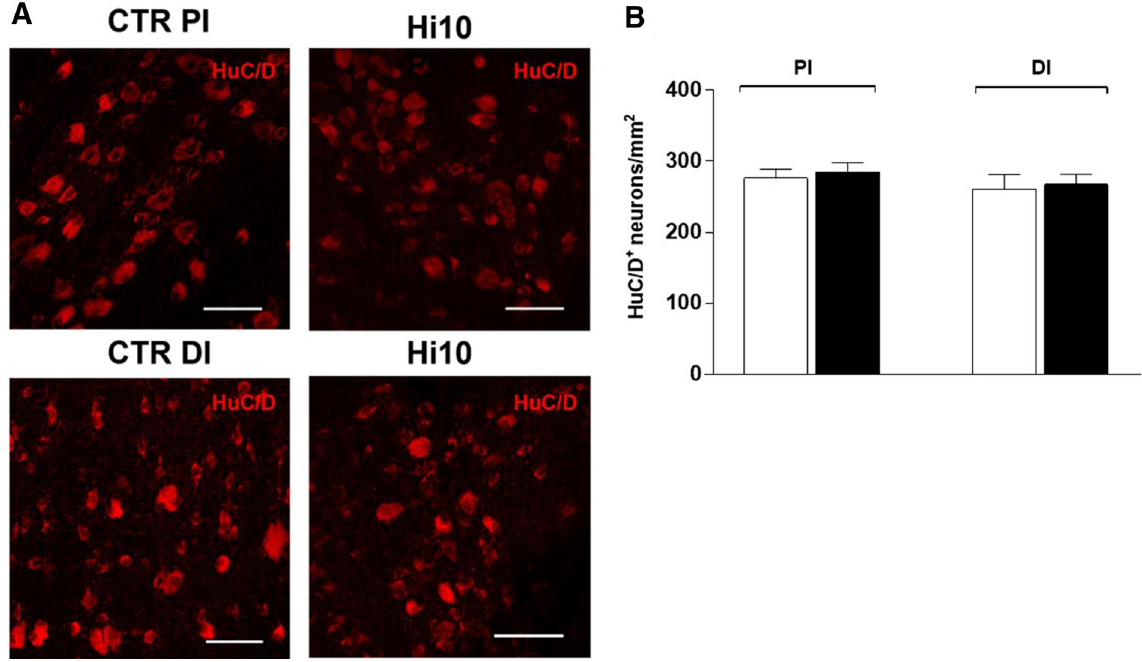
Figure 2. Density of myenteric neurons in longitudinal muscle myenteric plexus (LMMP) whole mounts of the proximal and distal gilthead sea bream. ( A ) HuC/D staining in LMMP preparations of the proximal and distal gilthead sea bream intestine obtained from fishmeal fed (CTRL) and Hermetia illucens 10% (Hi10) fed fish. Bars: 50 µm. ( B ) Number of myenteric neurons per mm 2 staining for HuC/D in gilthead sea bream proximal (PI) and distal (DI) intestine obtained from CTRL (empty bars) and Hi10 (black bars) animals. Values are given as mean ± SEM (n = 5 neurons, normalized per area (mm 2 ), was similar (proximal CTRL: 276.4 ± 12.87; proximal Hi10: 284.5 ± 13.6; distal CTRL: 261.1 ± 20.50; distal Hi10: 267.9 ± 14.17, N = 5; (data expressed as mean ± SEM) (Fig. 2 panel B). Gastrointestinal transit in CTRL and in Hermetia illucens fed gilthead sea bream. Partial sub- stitution of fishmeal with Hermetia illucens meal affected gilthead sea bream gastrointestinal motor function, as suggested by the slower gastrointestinal transit as compared to CTRL animals (Fig. 3, panel A). This is reflected by the significant ( P < 0.01) reduction in the geometric center (GC) of fluorescence distribution in Hi10 animals with respect to the value obtained in CTRL animals (Fig. 3, panel B). Gastric emptying was not significantly modified by Hermetia illucens meal as compared to CTRL diet (Fig. 3, panel C). Hermetia illucens meal influences the excitatory neuromuscular contractility of the proximal and distal intestine in gilthead sea bream. The longitudinal muscle of the proximal (PI) and distal (DI) intestine of CTRL animals showed spontaneous movements consisting of regular pendular contractions, which were significantly higher ( P < 0.01) in the distal than in the proximal intestine (Supplementary Table S2). In both intestinal regions, the amplitude of spontaneous contraction was significantly reduced after feeding with Hermetia illucens meal as compared to the relevant CTRL value (PI: P < 0.001; DI: P < 0.05). The frequency of spontaneous basal contractions was significantly higher in the proximal intestine than values obtained in the dis- tal intestine ( P < 0.01) (Supplementary Table S2). In both intestinal regions, Hermetia illucens meal significantly reduced the frequency of spontaneous contractions with respect to the relevant CTRL value ( P < 0.05 for both PI and DI; Supplementary Table S2). To evaluate the influence of Hermetia illucens meal on the excitatory neuromuscular response, non- cumula- tive concentration–response curves to the non-selective cholinergic agonist carbachol (CCh), were performed on longitudinally oriented proximal and distal intestine segments from all experimental groups. In the proximal intestine of the CTRL group, the concentration–response curve to CCh was lower than that obtained in the distal intestine of CTRL animals, with a significant decrease in maximum response (Emax) ( P < 0.0001) (Fig. 4, panel A). Hermetia illucens meal did not influence concentration–response curves to CCh in the proximal intestine as compared to CTRL fishmeal, whereas in the distal intestine, the insect meal induced a significant downward shift of the CCh concentration–response curve, with a significant reduction in Emax as compared to CTRL conditions ( P < 0.0001) (Fig. 4, panel A and B). Under all experimental conditions, EC 50 values of the concentration–response curves did not differ significantly [CTRL proximal intestine: 0.17 (0.05–0.52) µM, n = 6; Hi10 proximal intestine: 0.20 (0.02–0.68) µM, n = 6; CTRL distal intestine: 0.14 (0.08–0.24) µM, n = 6; and Hi10 distal intestine: 0.13 (0.06–0.28) µM, n = 6]. To further investigate potential changes in the excitatory contractile function induced by Hermetia illucens meal, the effect of EFS was evaluated at increasing frequencies of stimulation on the proximal